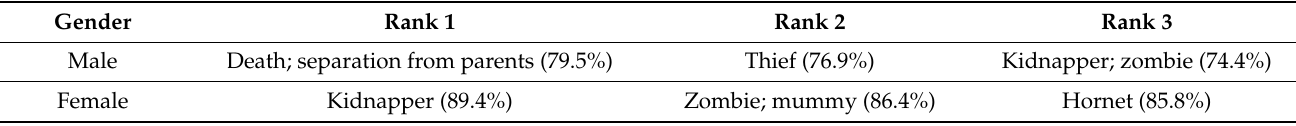
Table 5. Ranking of fear objects for different genders.